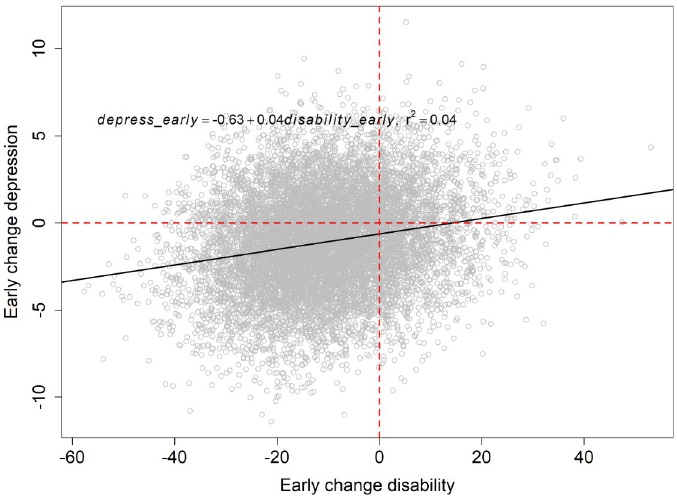
Fig 3. Posterior samples (104) of the relationship between an early change in disability against an early change in depressive symptoms, with associated linear relationship.